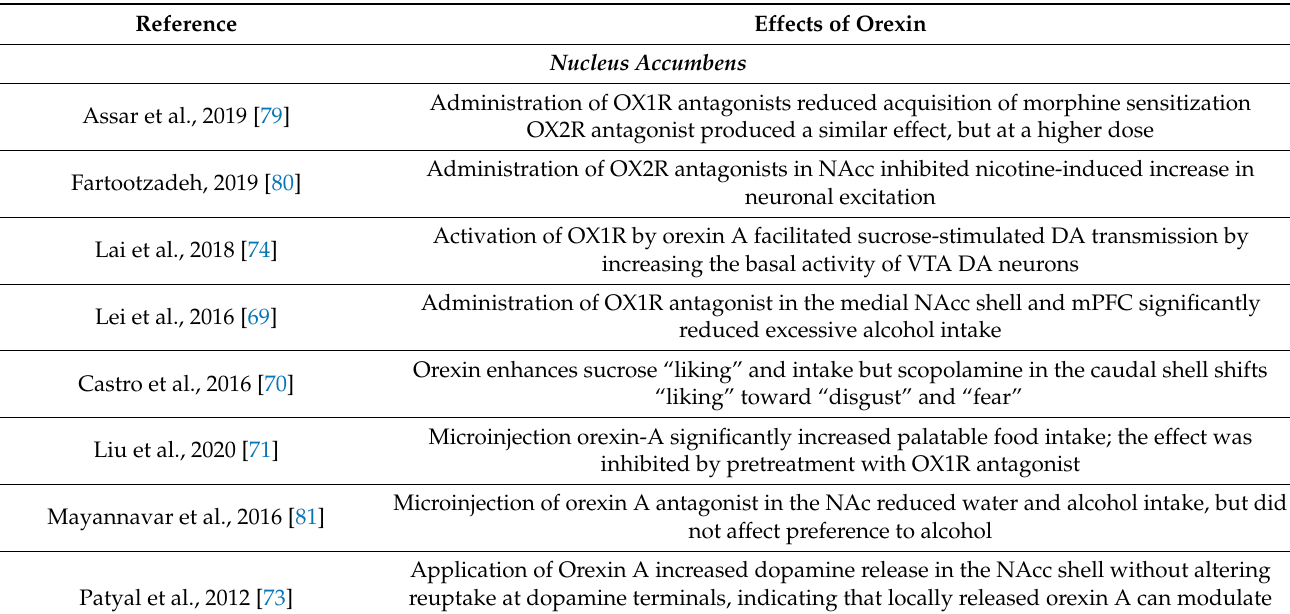
Table 1. Summary of animal studies showing behavioural effects of orexins in regions involved in the regulation of hedonic